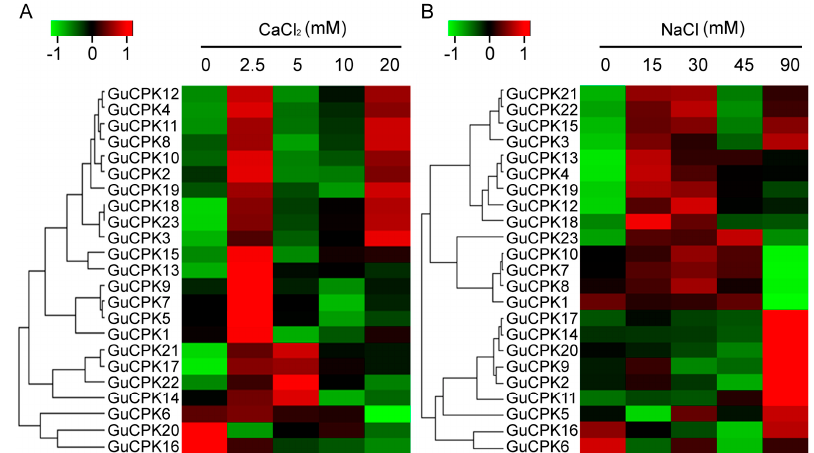
Figure 8. Heatmap of the expression levels of the 23 GuCPK genes in G. uralensis roots under di ff erent concentrations of CaCl 2 and NaCl treatments. ( A ) Heatmap of 23 GuCPKs under 0 mM, 2.5 mM, 5 mM, 10 mM, and 20 mM of CaCl 2 stimulations. ( B ) Heatmap of GuCPKs under 0 mM, 15 mM, 30 mM, 45 mM, and 90 mM of NaCl treatments. Each value is the mean of three independent replicates. GuCPK g enes that were highly or weakly expressed in different treated materials were colored by red or green, respectively. The color bar was indicated in the upper apex. The visualized heatmap was generated using R package on the basis of the qRT-PCR data.